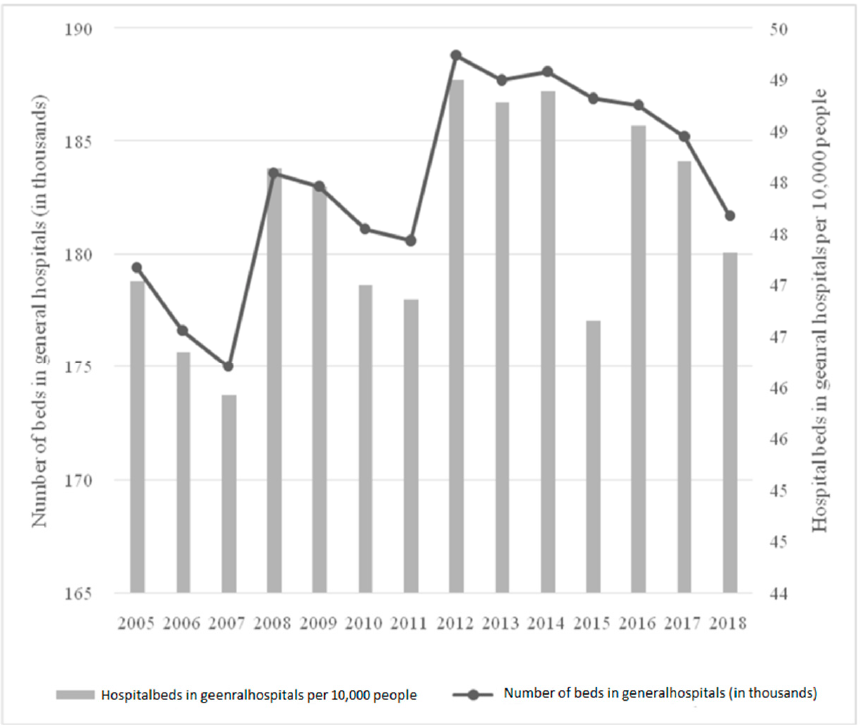
Figure 2. Hospital beds in Poland in 2005–2018 per 10,000 people and number of beds in general